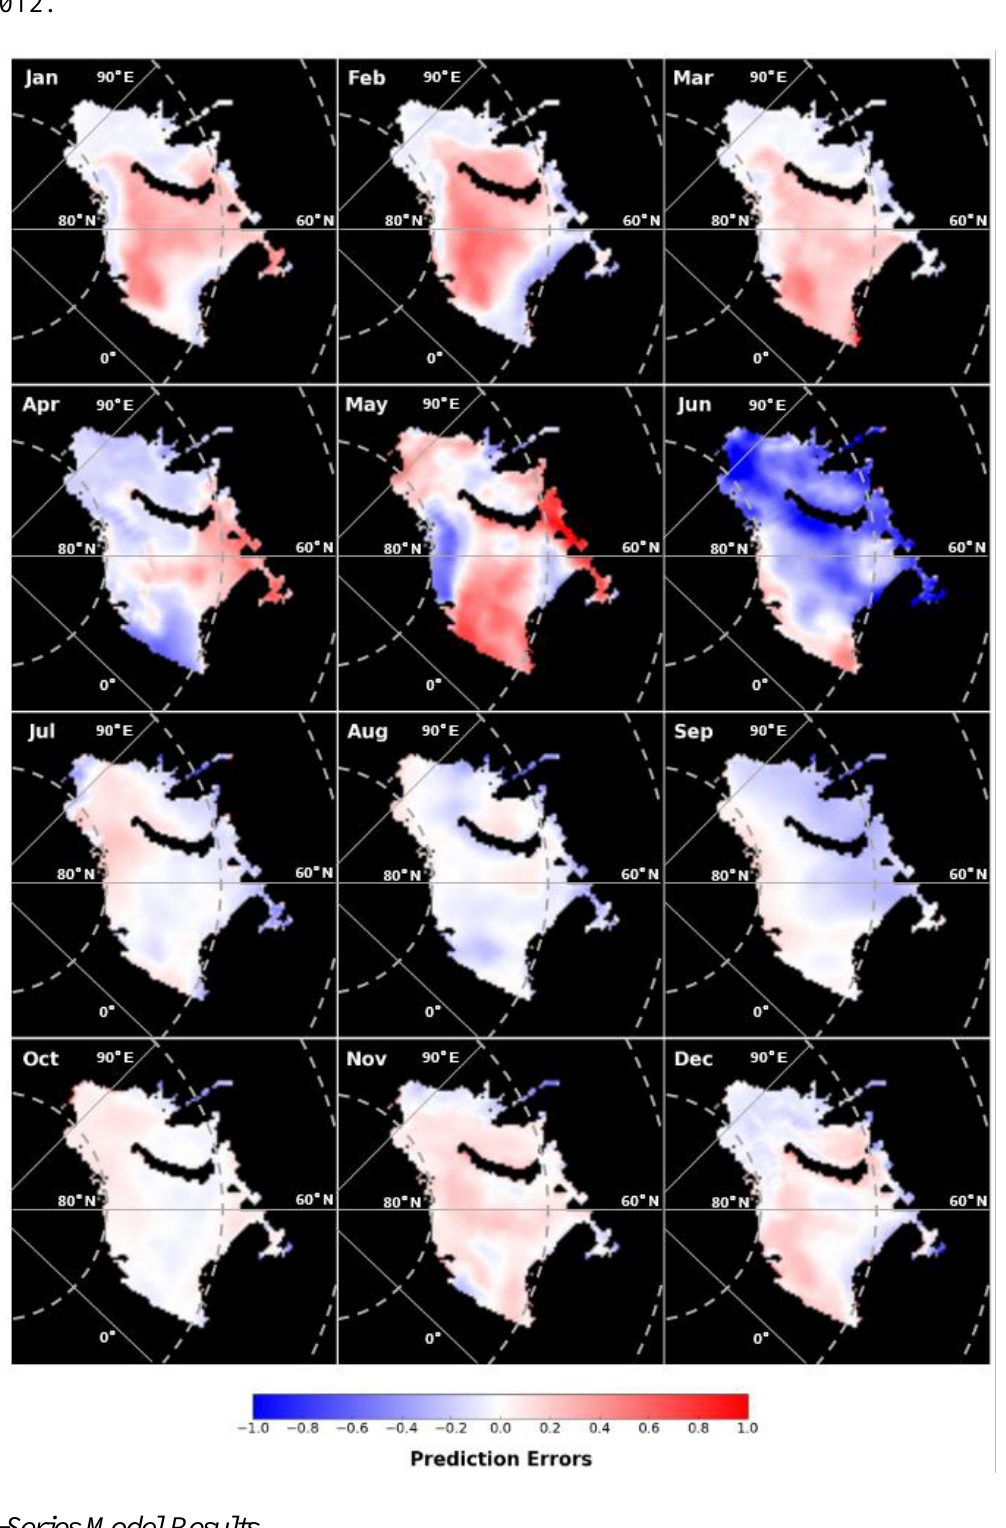
Figure 8. Prediction errors of the OLS regression models for the Barents and Kara Seas in